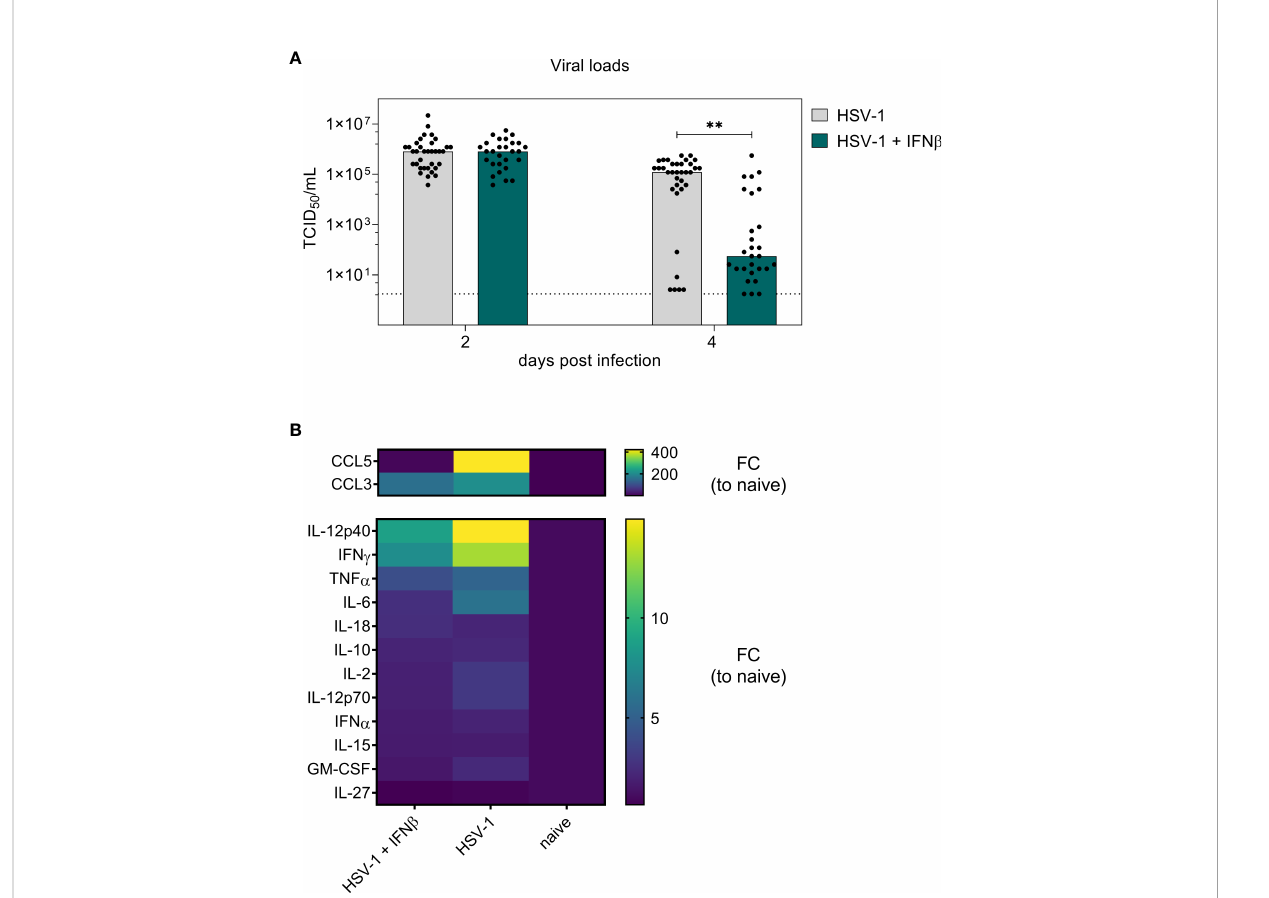
FIGURE 4 Early antiviral activity of IFN b on day 4 post vaginal HSV-1 infection. Female C57BL/6 mice were infected with 1×10 7 TCID 50 of HSV-1 F for four days or left uninfected (naive control). Mice were treated with 8000 U of murine IFN b for two consecutive days starting on day 2 p.i. or left untreated (HSV-1). On day 2 p.i . and day 4 p.i ., liquids from vaginal tract lavages were collected for determination of viral loads. After 4 days, spleens and vaginal tracts were isolated for further analysis of immune responses. (A) Viral titers of vaginal lavages were determined by endpoint dilution assay. Bars indicate the median virus titer of each group (HSV-1 n = 35 mice, HSV-1 + IFN b n = 28 mice). Dashed line represents the detection limit. Statistically signi fi cant differences of mean HSV-1 + IFN b titers compared to the initial viral load in infected mice were analyzed with the nonparametric Kruskal-Wallis test and are depicted by ** P < 0.01. (B) Fold change (FC) of CCL5 (RANTES), IFN a , IFN g , IL-10, IL-12p40, IL-12p70, IL-15, IL-18, IL-2, IL-6, TNF a , GM-CSF, CCL3 (MIP-1 a ), and IL-27 expression of vaginal lavages from HSV-1-infected mice untreated or IFN b -treated relative to naive mice. Mean values normalized to naive mice from 10 (HSV-1), 13 (HSV-1 + IFN b ), and 5 (naive) mice are